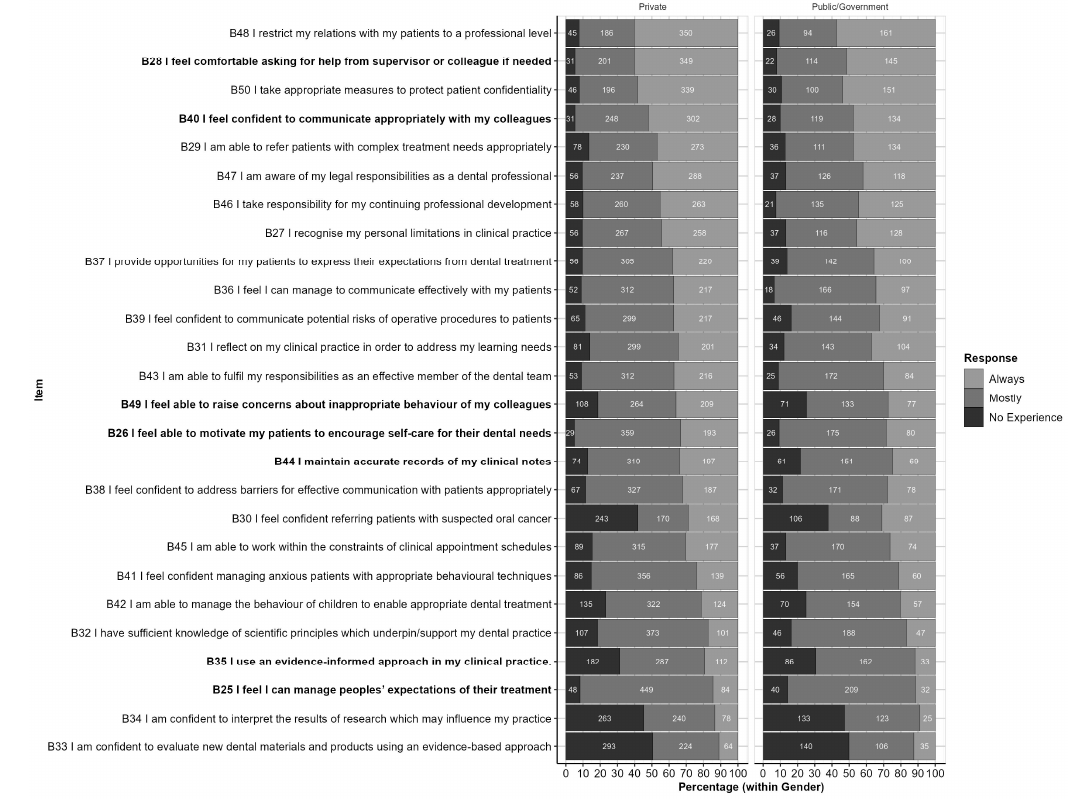
Figure 5. Responses by Part B items (within Institution Category): Responses are ordered from highest to lowest proportion of ‘Always’ responses (across Institution Categories). Items for which response profiles differ by Institution Category at the p < 0.05 level are high. Table 5. Association between Institution Category and Item Responses for Part B Specific p -values from Chi-Squared tests of association for items showing a statistically significant association be- tween Institution Category and Item Responses for Part B.